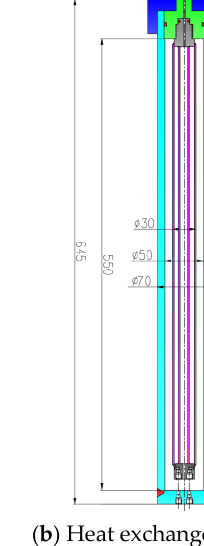
Figure 1. Wellbore self-circulation experiment system. In Figure 1a: (1) water tank, (2) advection pump, (3) intermediate container, (4) thermotank, (5) temperature sensor (four points, probe type), (6) granite jacket or quartz sand cylinder, (7) temperature sensor (three points, patch type), (8) outer casing, (9) inner tubing (hollow inside, filled with thermal conductivity materials or vacuum), (10) pedestal, (11) low-temperature water bath, (12) buffer tank, (13) plunger metering pump, (14) pressure sensor (two points), (15) data collection box, and (16) computer.